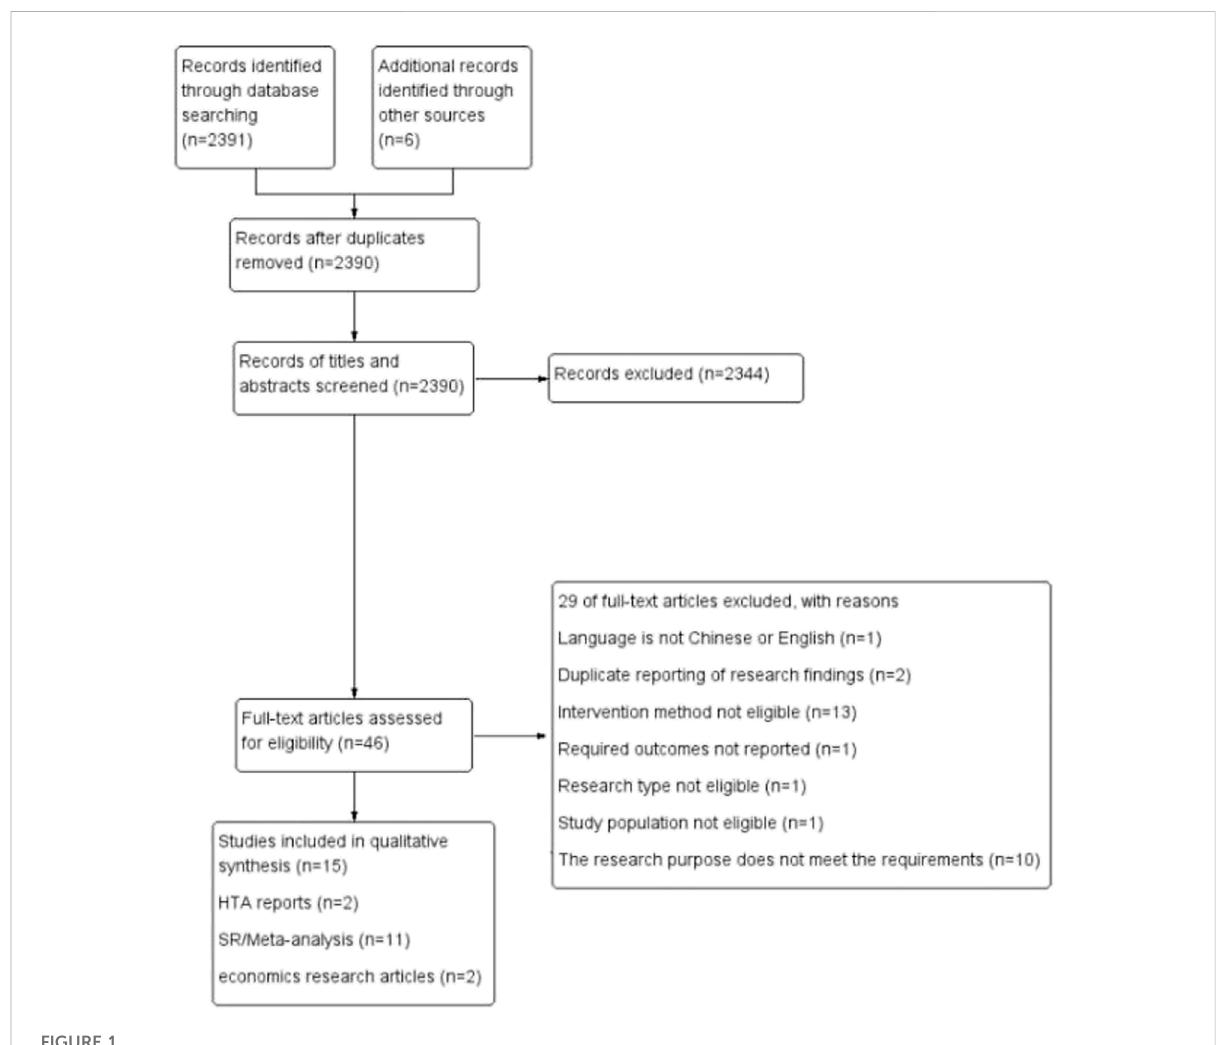
FIGURE 1 Flow chart of literature